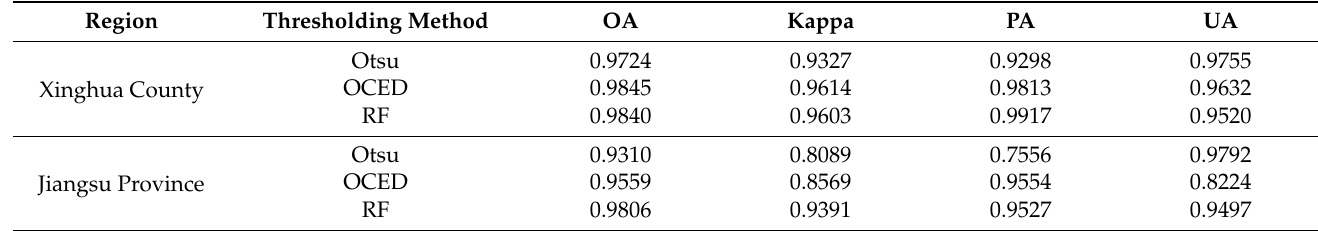
Figure 9. The zoom-in view of ( a ) site A, ( b ) the red box of site A, ( c ) site B, and ( d ) the red box of site B. Row (1) shows the pseudo-true-color composite image of positions ( a – d ). Rows (2–4) display the OCED-THAT-based, Otsu-THAT-based, and Random Forest-based rapeseed maps corresponding to places in row (1). Here, OCED means Otsu with Canny Edge Detection thresholding algorithm, and THAT means two-stepwise hierarchical adaptive thresholding method. Table 6. Accuracy of different rapeseed mapping